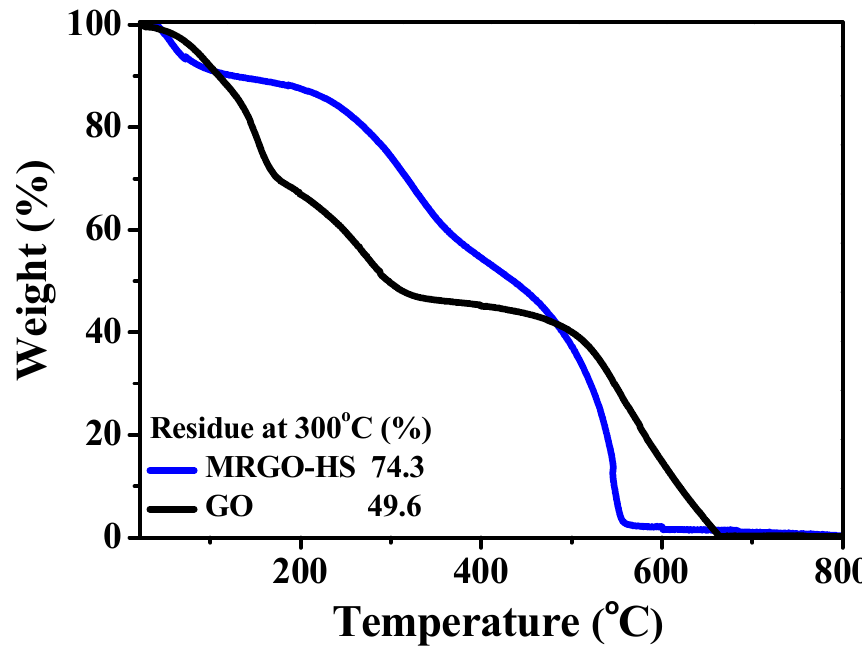
Figure 10. TGA curves of MRGO-HS and GO.